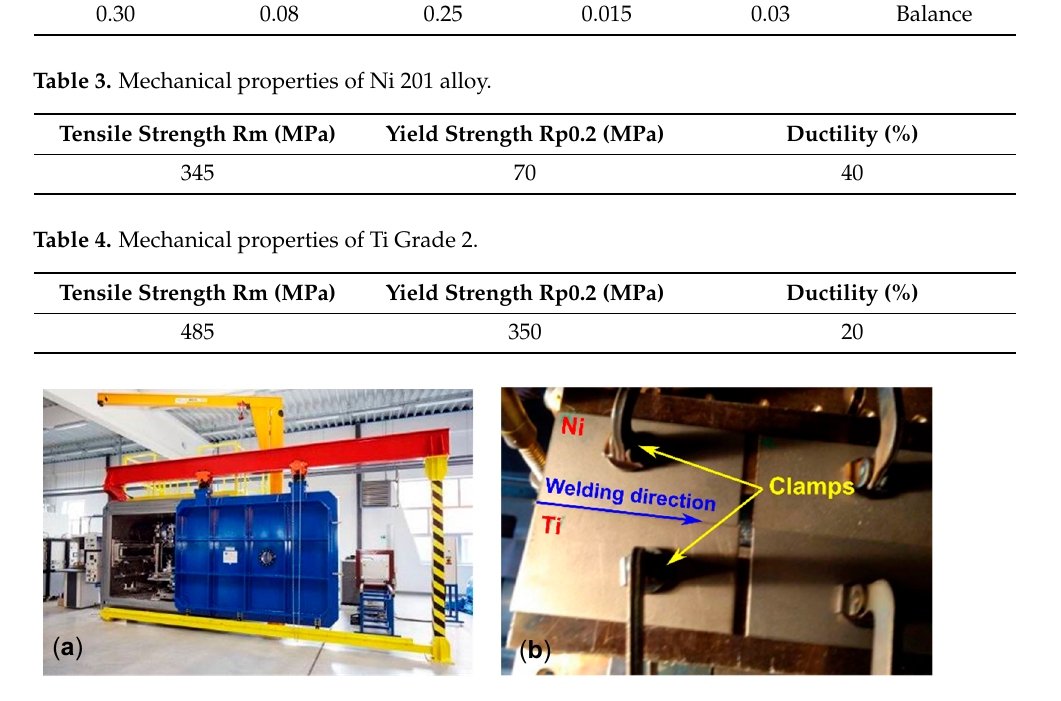
Figure 2. Electron beam welding workplace—vacuum chamber ( a ); setup and clamping of welded materials ( b ). Table 5. Electron beam welding